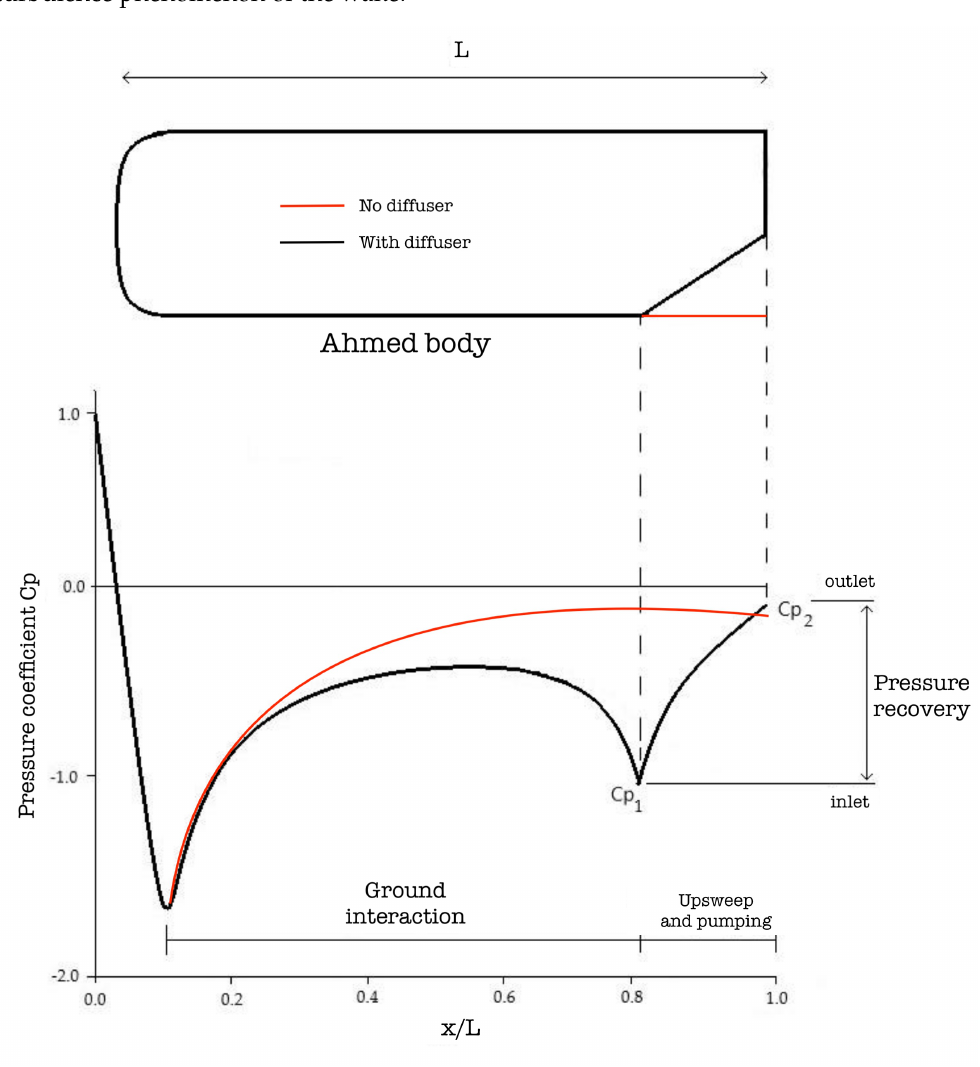
Figure 5. Pressure coefficient curve around a bluff